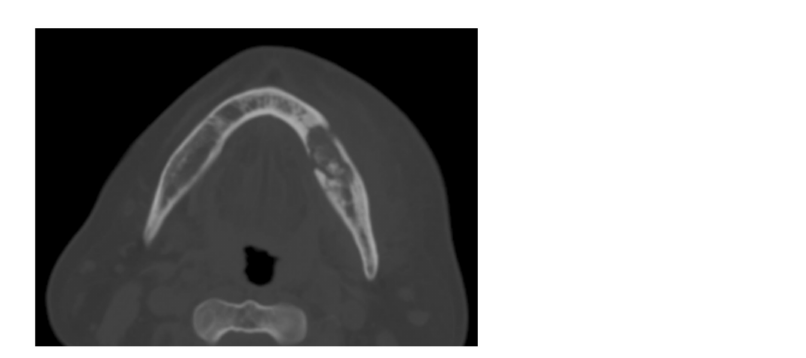
Figure 1. Pre-operative computed tomography (CT) scan showing medication-related osteonecrosis of the jaws (MRONJ) of her left mandible (36–38 area).